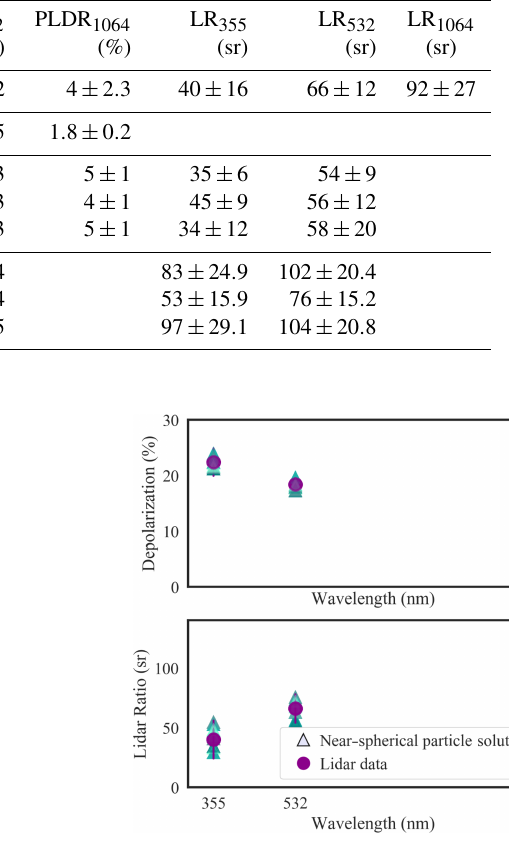
Figure 9. The reproduction of the measured PLDR and LR val- ues, considering near-spherical particles. Purple circles correspond to measurements performed on 22 August 2017, in Leipzig, Ger- many, while purple lines correspond to the measurement uncertain- ties. Different light blue colour triangles denote simulations per- formed with the T-matrix code, assuming near-spherical particles. Each light blue triangle corresponds to a different solution found to reproduce the measurements within their uncertainties, as given in Table 3. For these solutions, the mean axial ratio ε s ranges from 1.1 to 1.4, the mean geometric radius r g ranges from 0.25 to 0.45µm, and the wavelength-independent complex refractive index m ranges from 1.35 to 1.55 for the real part (mrr) and from 0.005 to 0.03 for imaginary part